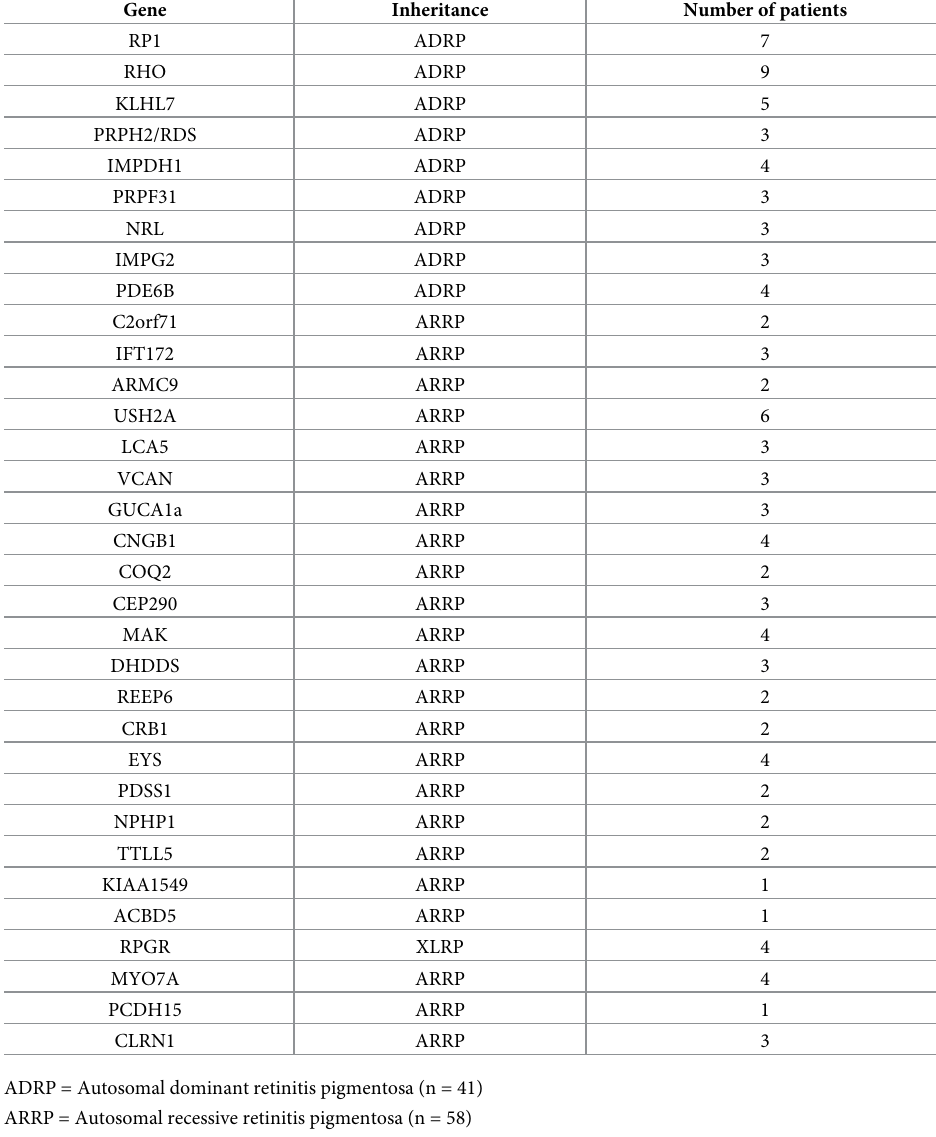
Table 1. Causative genes and inheritance patterns of the patients.